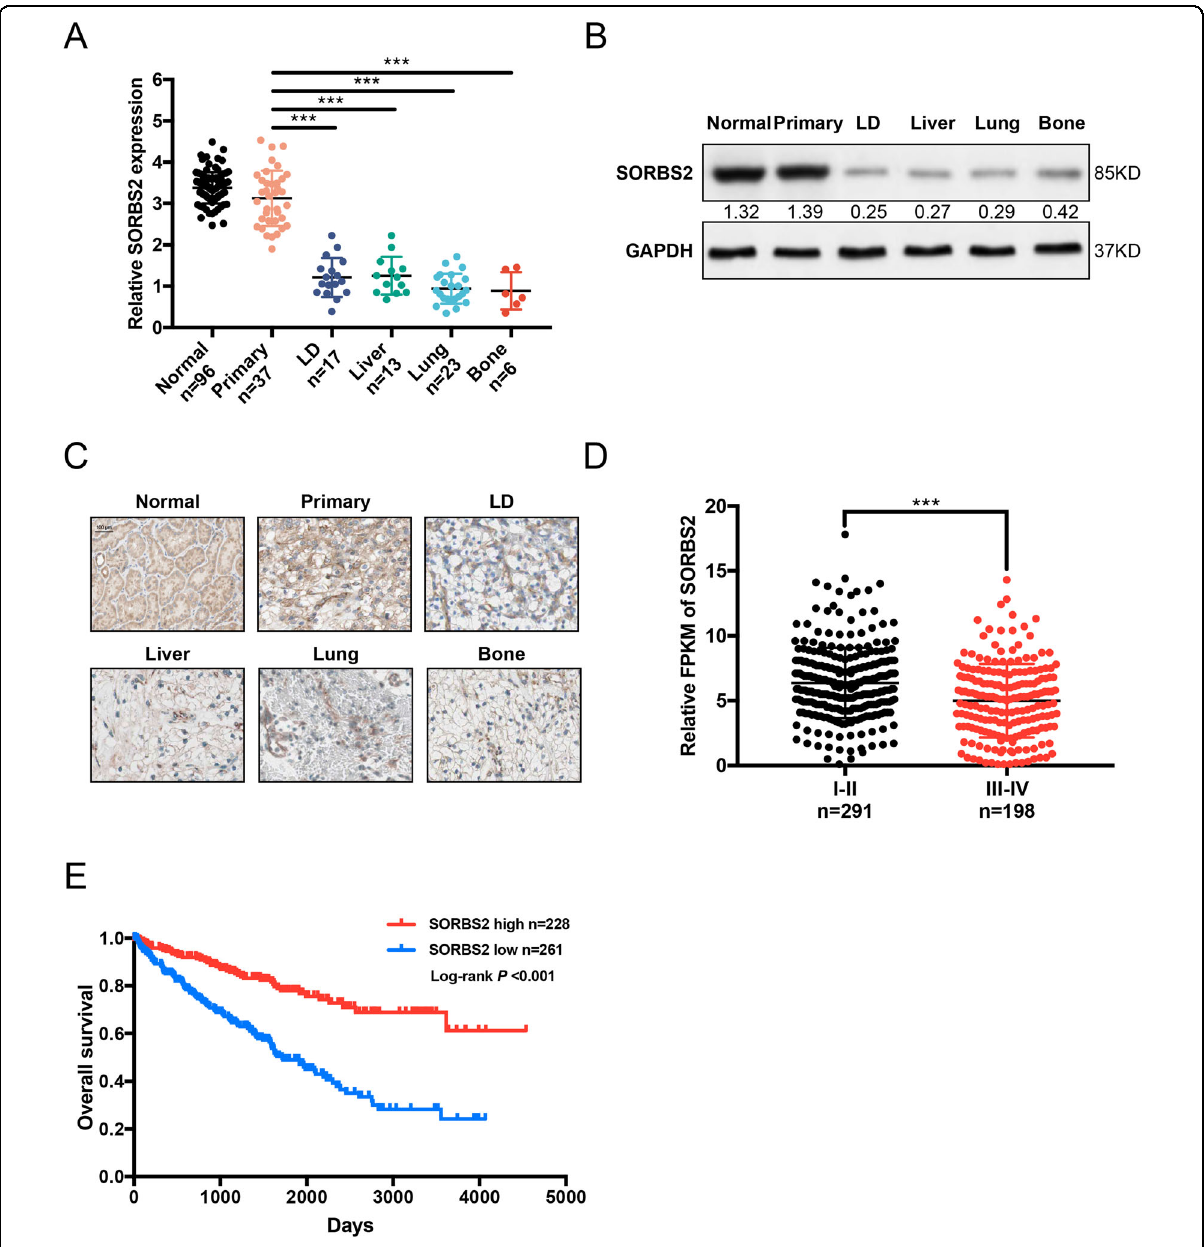
Fig. 1 SORBS2 downregulation in ccRCC tissues and its association with poor prognosis. A Expression analysis by qRT-PCR of SORBS2 mRNA in different tissues. B Expression analysis by western blot of SORBS2 protein in different tissues. C Immunohistochemistry analysis of SORBS2 in different comparing overall survival in ccRCC patients with high or low SORBS2 expression; the average expression of SORBS was used as a cut-off value for grouping. *** P <